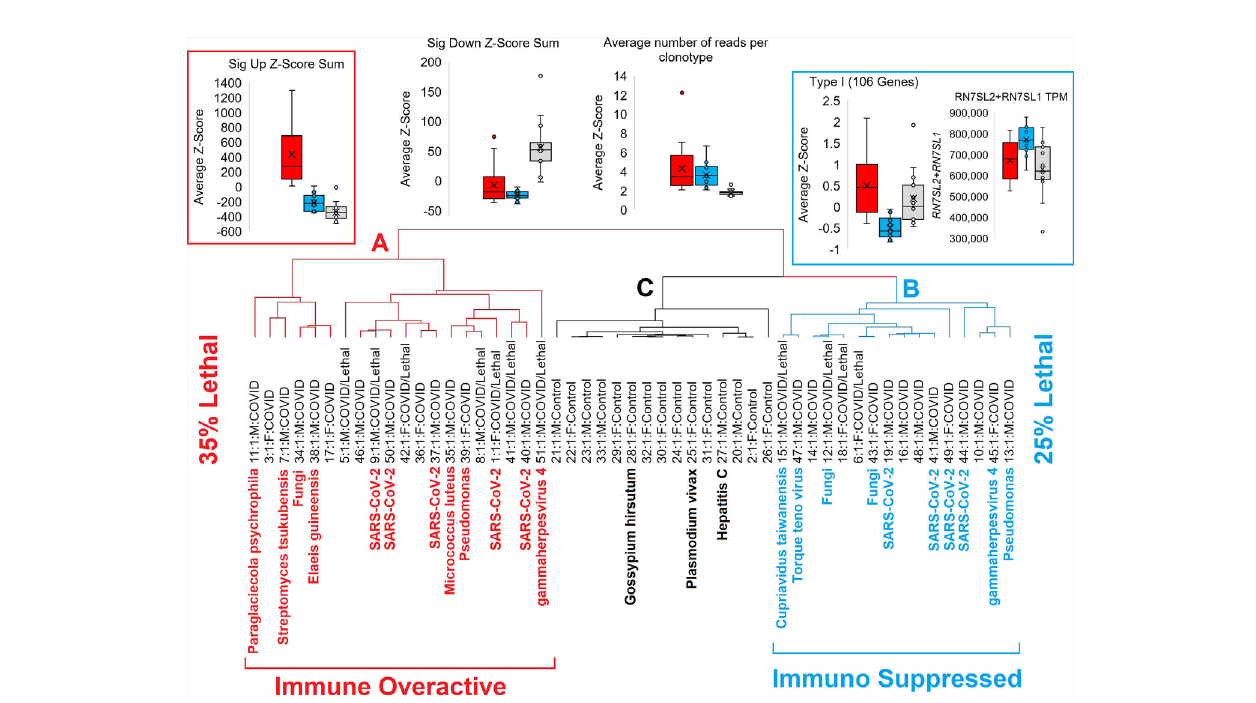
FIGURE 9 | Schematic of two different groups of COVID patients relative to controls. Red represents the immune overactive COVID-19 patients (group A), cyan the immune suppressed patients (group B), and controls cluster in black (group